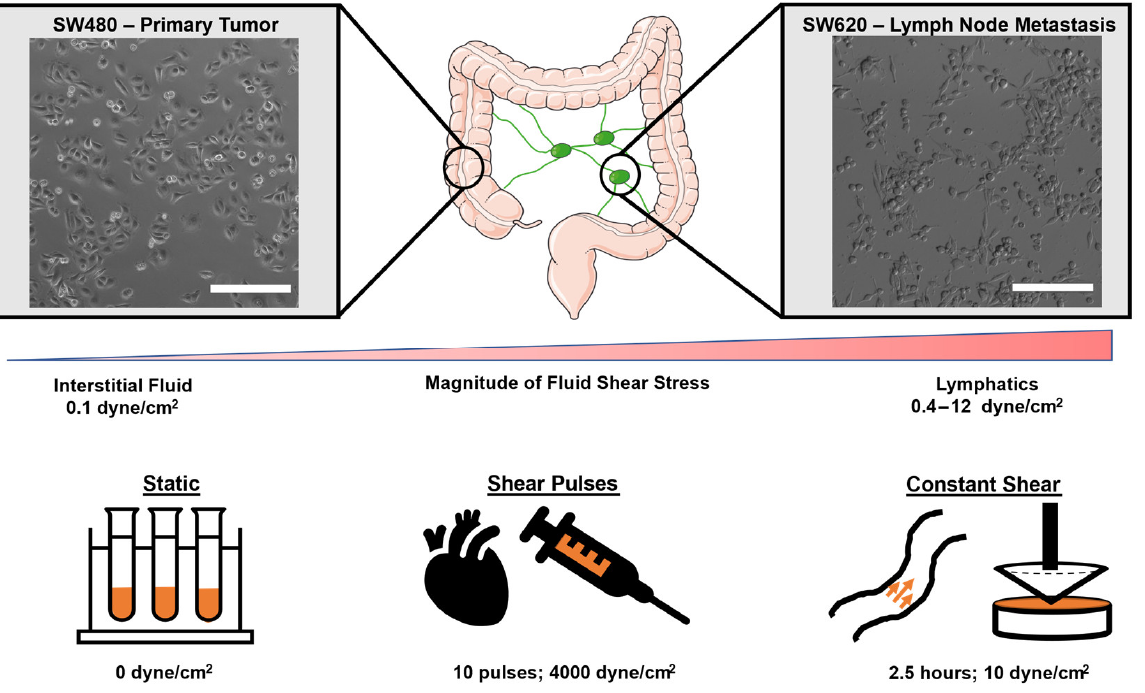
Figure 1. Isogenic colorectal cancer cellular model with different exposures to FSS in situ. FSS conditions were chosen to model flow conditions experienced by CTCs at brief intervals of turbulence (shear pulses) and average magnitudes and durations in the vasculature (constant shear).